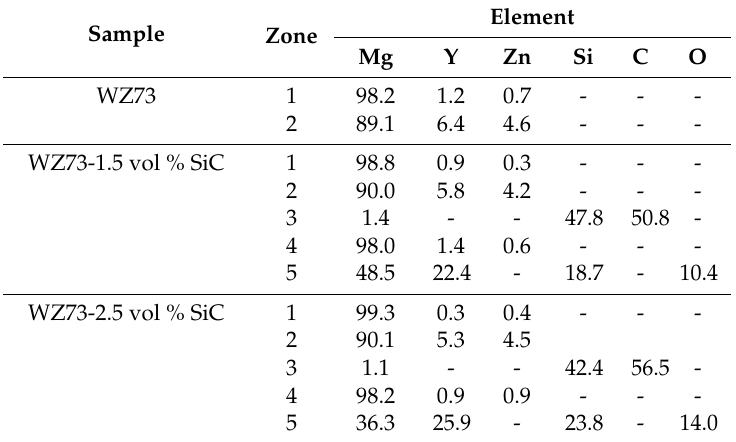
Figure 3. X-ray Diffraction (XRD) patterns of WZ73 and MMCs: ( a ) WZ73; ( b ) WZ73-1.5 vol% SiC; ( c ) WZ73-2.5 vol% SiC and ( d ) Zoom in of the peaks of SiC and Mg 12 YZn in a 2 theta range of 35° to 39°. Table 1. Chemical composition of selected areas in the WZ73 alloy and MMCs (at %).